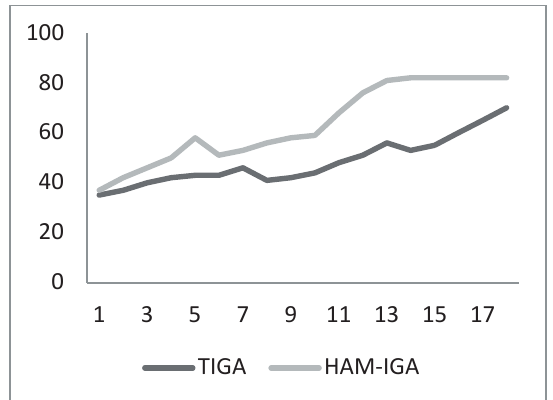
Fig.7. Changing Curve of Evaluation Value